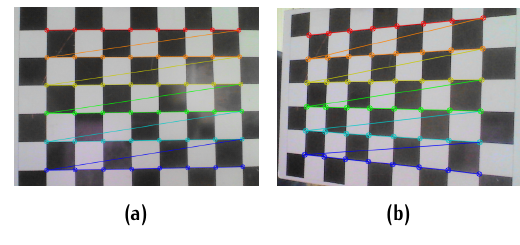
Figure 2. Pattern corners